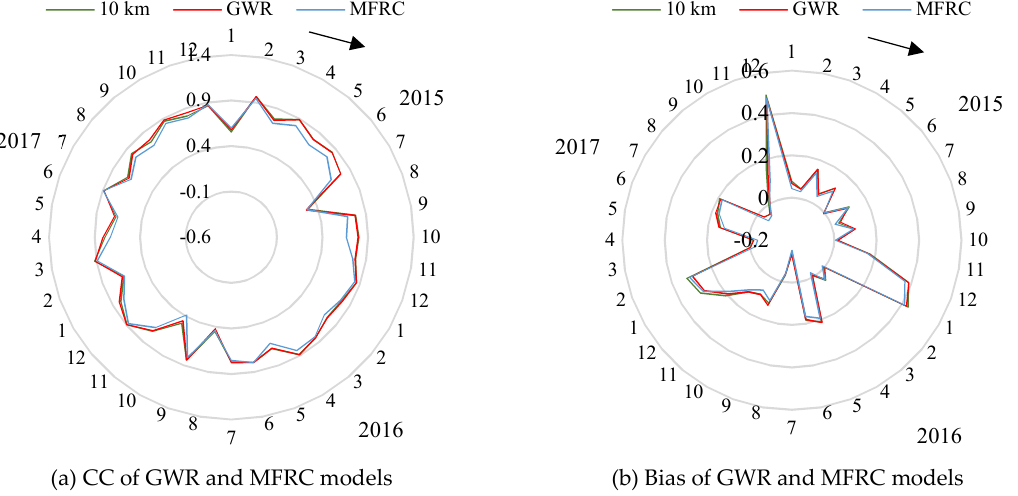
Figure 11. Accuracy assessment of different downscaled results from GWR and MFRC models. ( a ) CC of GWR and MFRC models, ( b ) Bias of GWR and MFRC models. Compared to the GPM/IMERG-based 10 km precipitation fields, the downscaled results of the GWR and MFRC models can remain with the same accuracy as the mean CC values of the GWR/MFRC models, which are 0.771 and 0.731, respectively, and the mean Bias values of the GWR/MFRC models are 14.018% and 11.865%, respectively, where the data points and lines are severely overlapped in Figure 11.